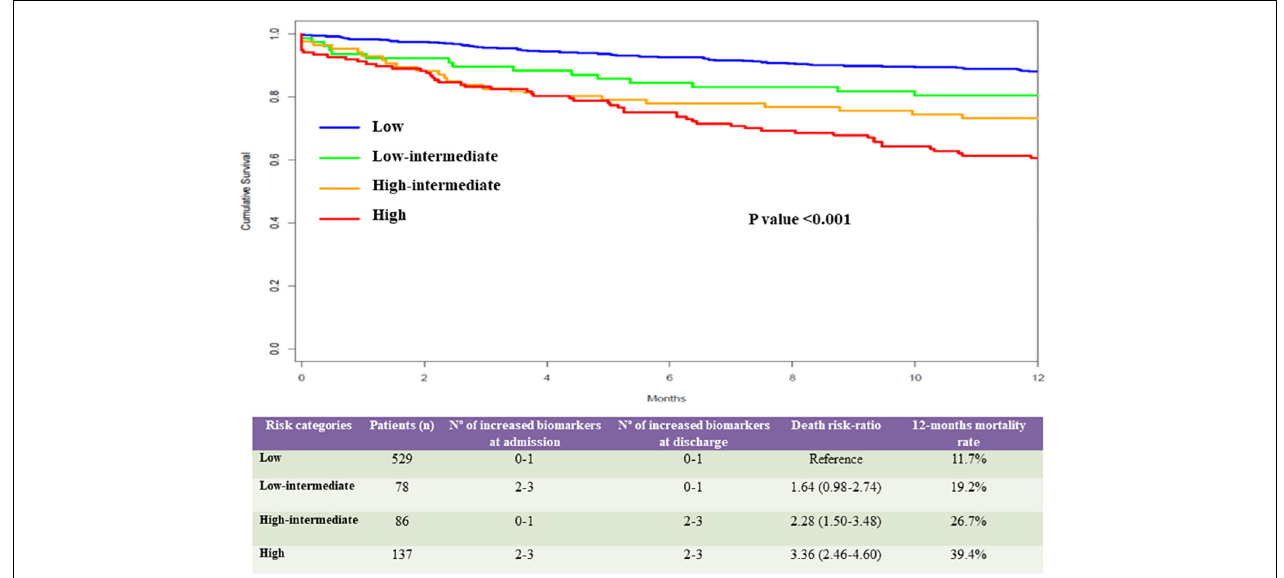
FIGURE 1 | Risk categories based on the values of NT-proBNP, hs-CRP, and GDF-15 in the study population. Upper panel: our study identified 4-risk categories for 12-month all-cause mortality based on the values of NT-proBNP, hs-CRP, and GDF-15: (1) a low-risk category (blue line) included 529 patients presenting none or 1 biomarker above the cutoff values at admission and discharge, (2) a low-intermediate risk category (green line) included 78 patients presenting 2 or 3 elevated biomarkers at admission and none or 1 at discharge, (3) a high-intermediate category (orange line) included 86 patients presenting none or 1 elevated biomarker at admission and 2 or 3 elevated biomarkers at discharge, and (4) a high-risk category (red line) included 137 patients presenting 2 or 3 elevated biomarkers both at admission and discharge. Bottom panel: The 12-month mortality rate for these 4 categories was, respectively, 11.7, 19.2, 26.7, and 39.4%. Considering the low risk category as reference, the mortality risk-ratio was 1.64 (95% CI: 0.98–2.74) for the low-intermediate; 2.28 (95% CI: 1.50–3.48) for the high-intermediate; and 3.36 (95% CI: 2.46–4.60) for the highest risk